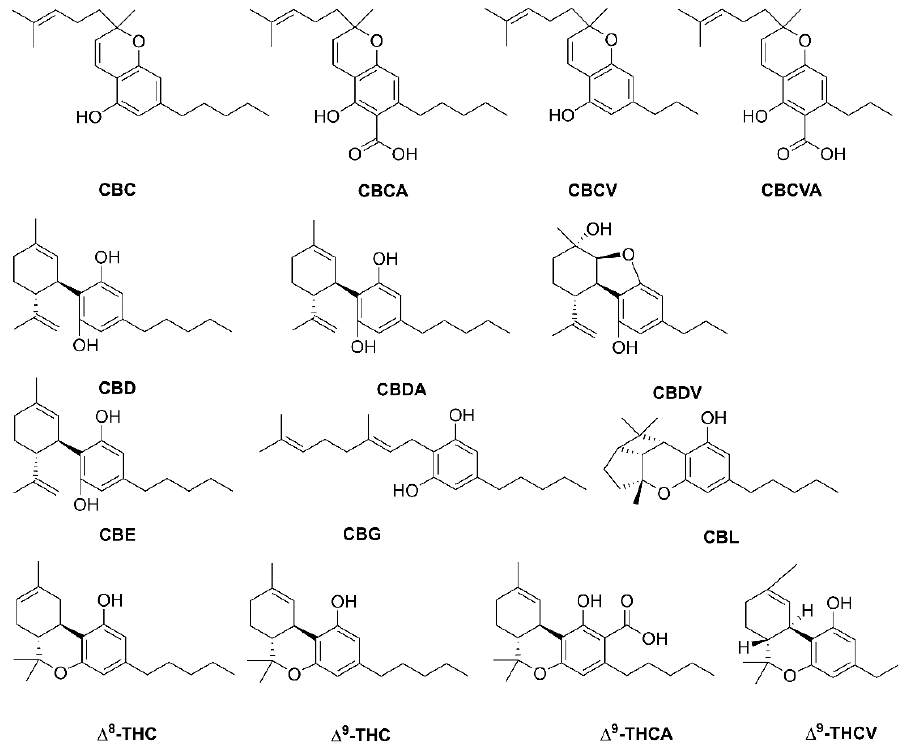
Figure 1. Structure of phytocannabinoids in Cannabis sativa . Abbreviations: CBC, cannabichromene; CBCA, cannabichromenic acid; CBCV, cannabichromevarine; CBCVA, cannabichromevarinic acid; CBD, cannabidiol; CBDA, cannabidiolic acid; CBDV, cannabidivarine, CBE, cannabielsoin; CBG, cannabigerol; CBL, cannabicyclol; ∆ 8 -THC, ∆ 8 -tetrahydrocannabinol; ∆ 9 -THC, ∆ 9 -tetrahydrocannabinol; ∆ 9 -THCA, ∆ 9 -tetrahydrocannabinolic acid; ∆ 9 -THCV, ∆ 9 -tetrahydrocannabivarinic acid.